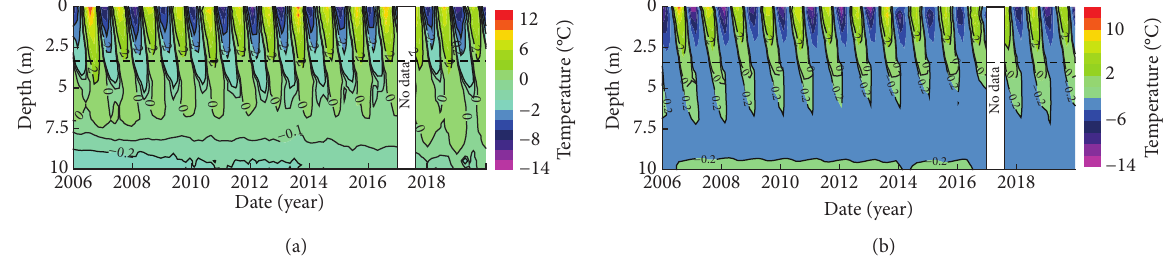
Figure 4: Ground temperature isotherms at the sunny shoulder (a) and the shady shoulder (b). The dotted line in the figure represents the original natural